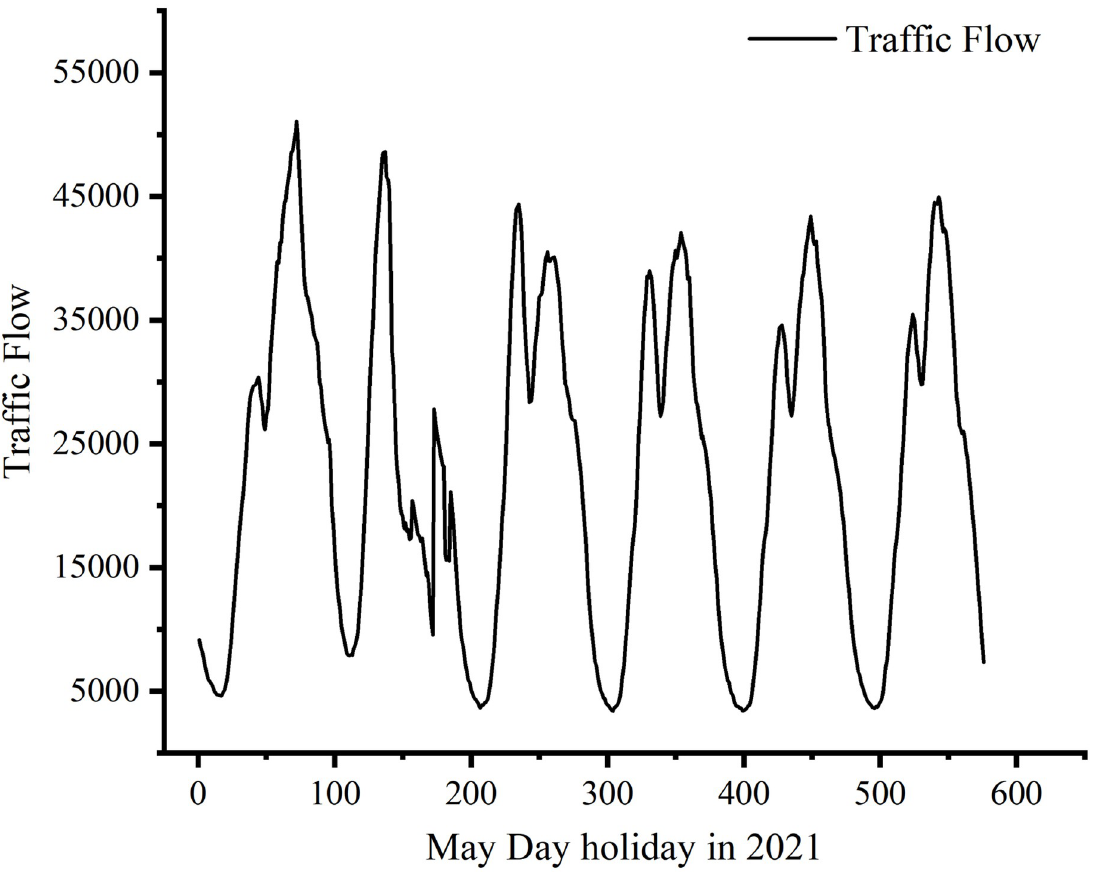
Fig 1. Traffic flow of Fuzhou-Xiamen expressway on May Day